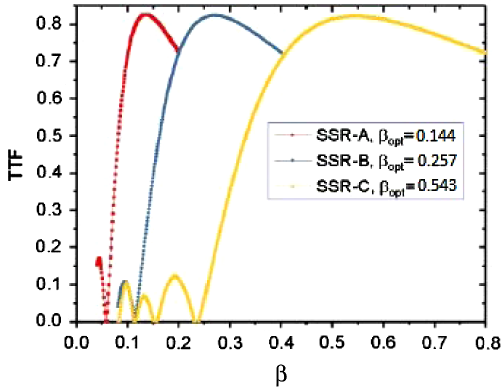
FIG. 19. Transit time factor as a function of β for the SSR-A, SSR-B, and SSR-C